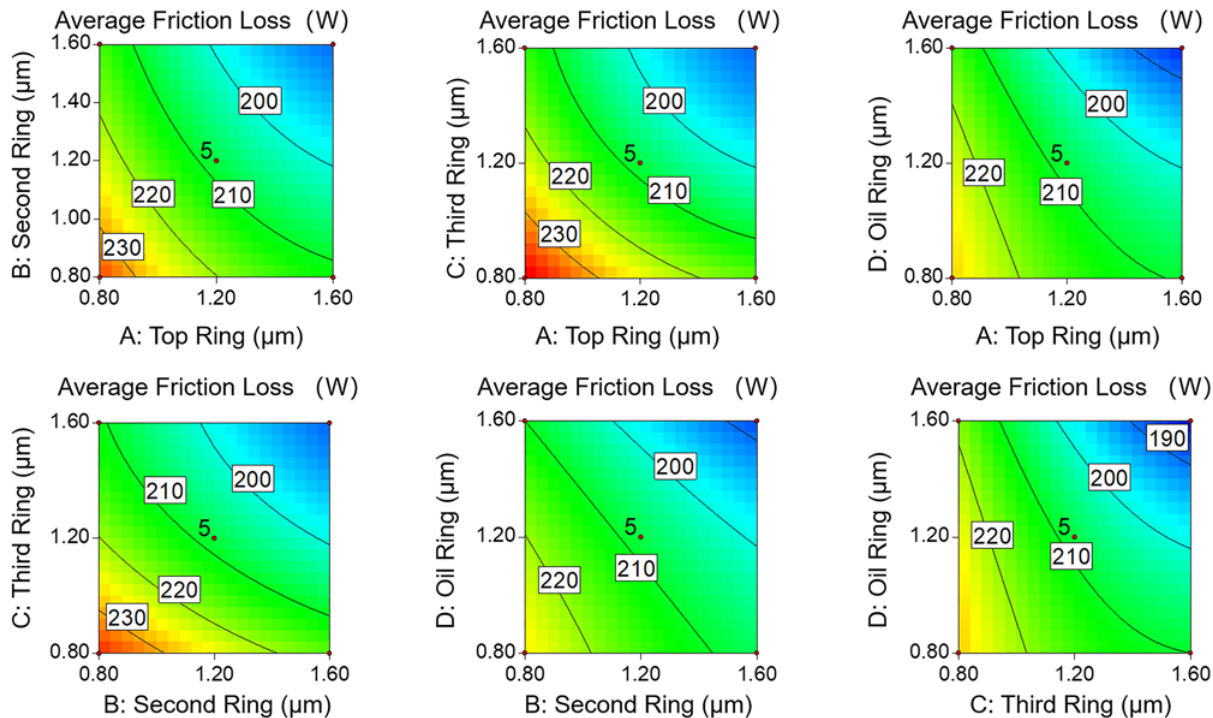
Fig. 19. Effect of surface roughness of individual piston rings on the average friction